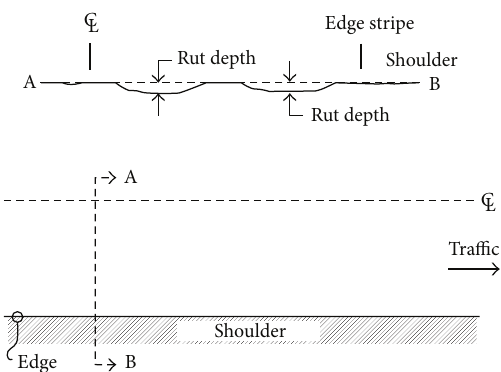
Figure 1: Schematic representation of rutting